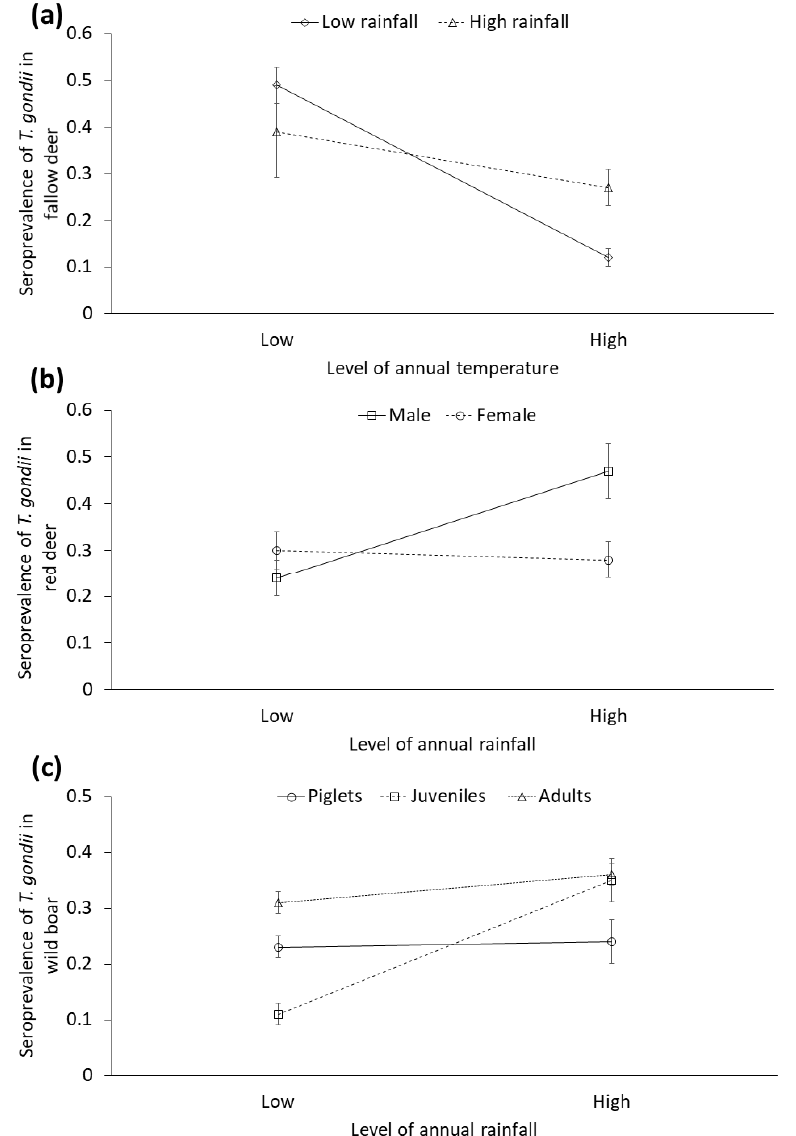
Figure 6. Seroprevalence ( ± CI 95%) of Toxoplasma gondii obtained from selected generalized linear mixed models (GzLMMs) in ( a ) fallow deer depending on the interaction between annual rainfall (mm) and temperature (°C), ( b ) red deer depending on the interaction between annual rainfall (mm) and sex, and ( c ) wild boar depending on the interaction between annual rainfall (mm) and age.